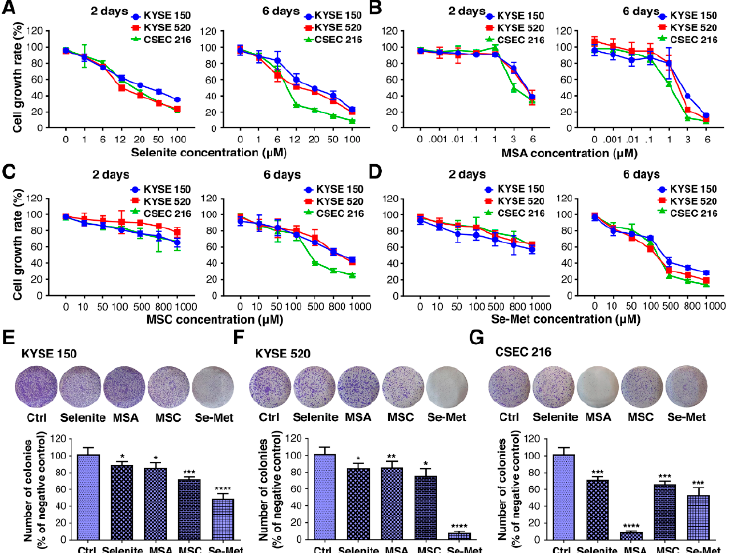
Figure 1. Selenium prevents cell proliferation and colony formation in ESCC cell lines. Respective ESCC cell lines were treated with increasing concentrations of ( A ) selenite, ( B ) MSA, ( C ) MSC, and ( D ) Se-Met for 2 days and 6 days, followed by the CCK8 assay and was calculated by the following formula: cell viability (%) = (OD 570 of the treatment samples/OD 570 of the control samples) × 100%. Results in triplicate represent the percentages (mean values ± SD) of cell growth to the untreated control. Colony formation assay was performed in ( E ) KYSE 150, ( F ) KYSE 520, and ( G ) CSEC 216 exposed to Se compounds for 14 days before being stained with crystal violet. Concentrations used were: 6 µM (selenite), 100 µM (MSC, Se-Met) and 2 µM (MSA). The cell colonies were photographed, and the number of colonies was counted. The differences were significant at (* p < 0.05, ** p < 0.01, *** p < 0.001, **** p < 0.0001 vs. untreated control, n ≥ 3). Data are expressed as mean ± SD from three ( n = 3) independent experiments. The difference with p ≤ 0.05 was considered statistically